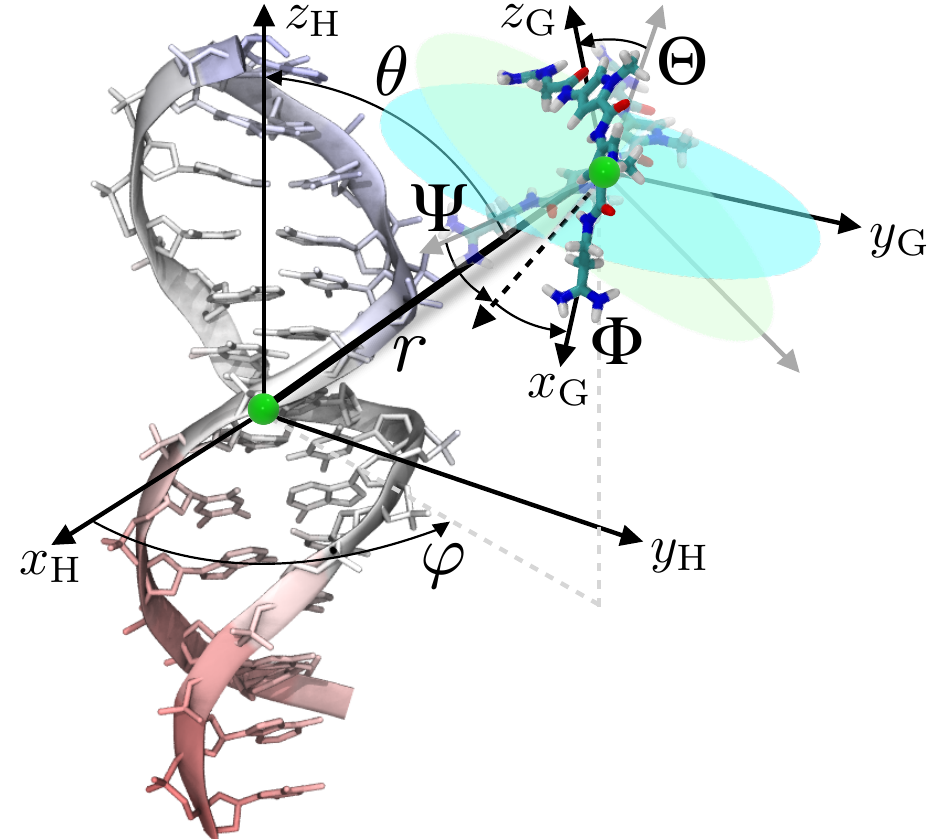
Figure 5. Degrees of freedom considered in the binding free-energy calculation illustrated in the case of netropsin binding to a double-stranded B-DNA segment. The Euler angles, Θ , Φ and Ψ , and the spherical-coordinate angles, θ and ϕ , describe the relative orientation and position of the guest with respect to the host,